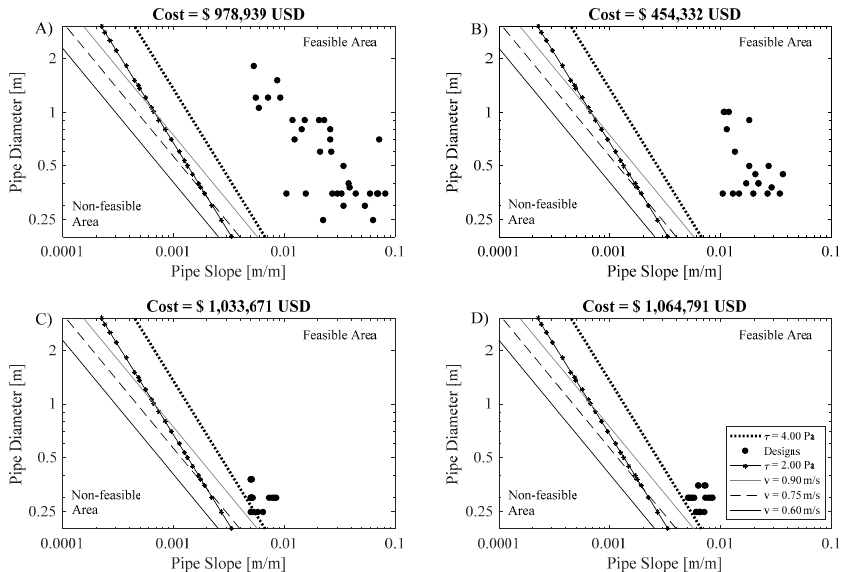
Figure 2. Design results and total costs for the three networks: ( A ) Mini-Chicó, ( B ) Mays and Wenzel [13], ( C ) Kerman city Design I, and ( D ) Kerman city Design II.